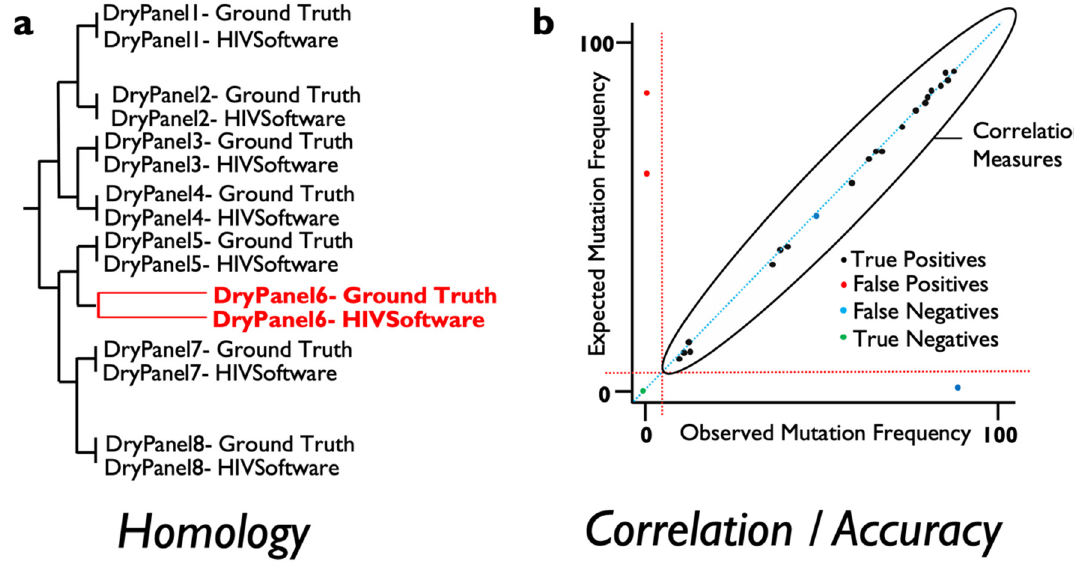
Figure 1. Types of proposed accuracy measures to be evaluated for next generation sequencing (NGS)-based HIV drug resistance testing (DRT) dry panels. ( a ) Using NGS-derived consensus sequences, a phylogenetic tree can be calculated with ground truth and software results in order to assess phylogenetic identity; ( b ) Using mutation frequencies as detected in NGS data, mutations can be classified as detected / not-detected at specified thresholds and derived accuracy measures can be used to validate software tools. In addition, a direct correlation using ground truth and obtained mutation frequencies can be calculated for each sample or samples group.